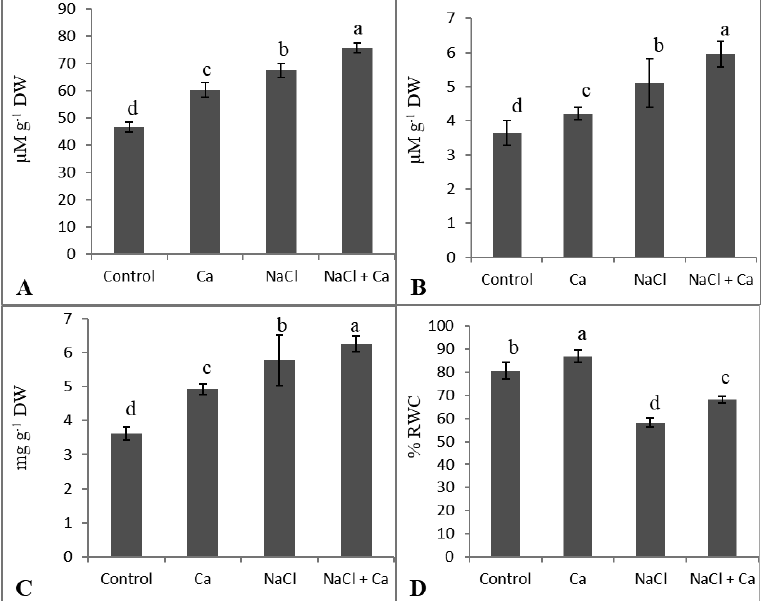
Fig. 3: Effect of salinity stress (100 mM NaCl) on content of ( A ) proline, ( B ) glycine betaine, ( C ) soluble sugars and ( D ) relative water content (RWC) in soybean ( Glycine max L.) with and without calcium supplementation. Data is mean (±SE) of three replicates and bars with different letters denote significant difference at P ≤ 0.05